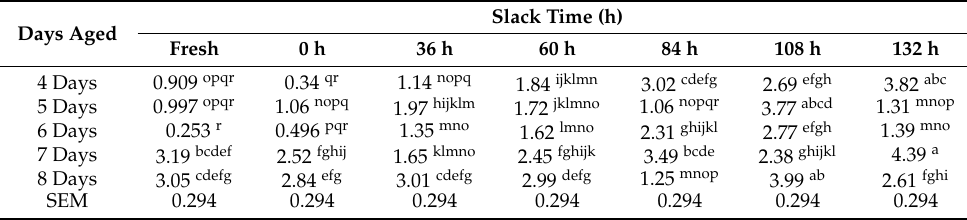
Table 2. Interactive impact (Days aged 1 × Slack time 2 ) lactic acid bacteria values 3 of the chicken tenderloins during simulated food service shelf-life.